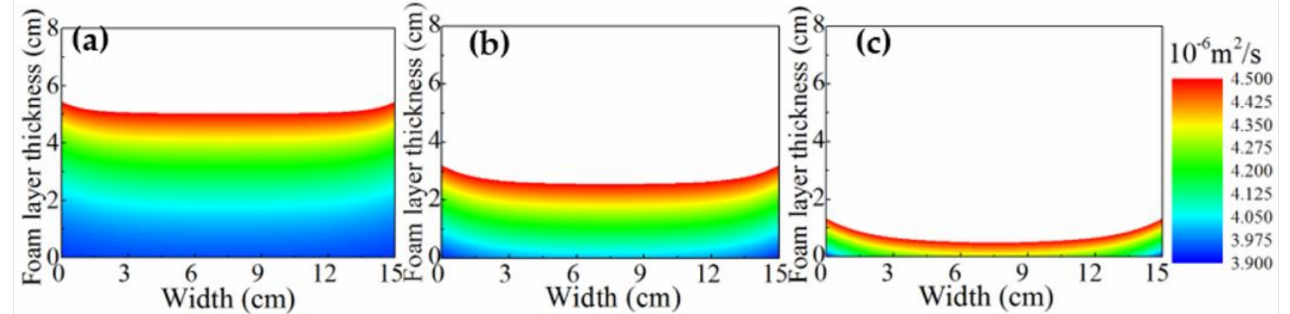
Figure 6. Contour of the foam layer thermal diffusivity under the typical operating conditions at different heating times. ( a ) t = 4 min, ( b ) t = 8 min, and ( c ) t = 12 min.